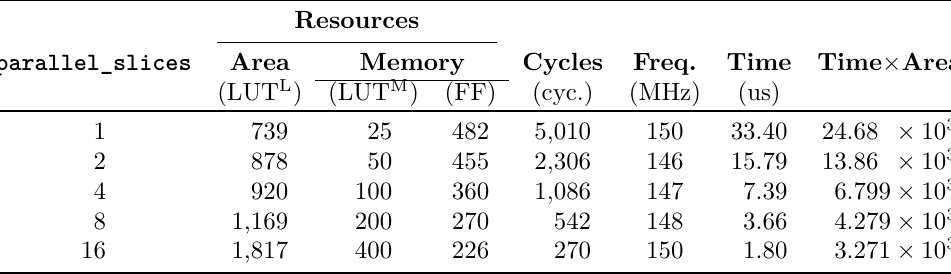
Table 5: Comparison of the time and area for our SHAKE256 module targeting Xilinx Artix 7 ( xc7a200t )